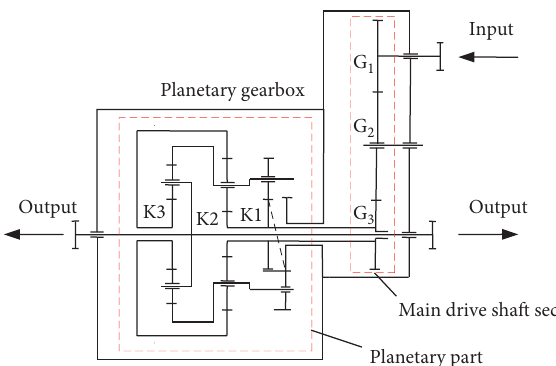
Figure 2: Planetary gearbox transmission